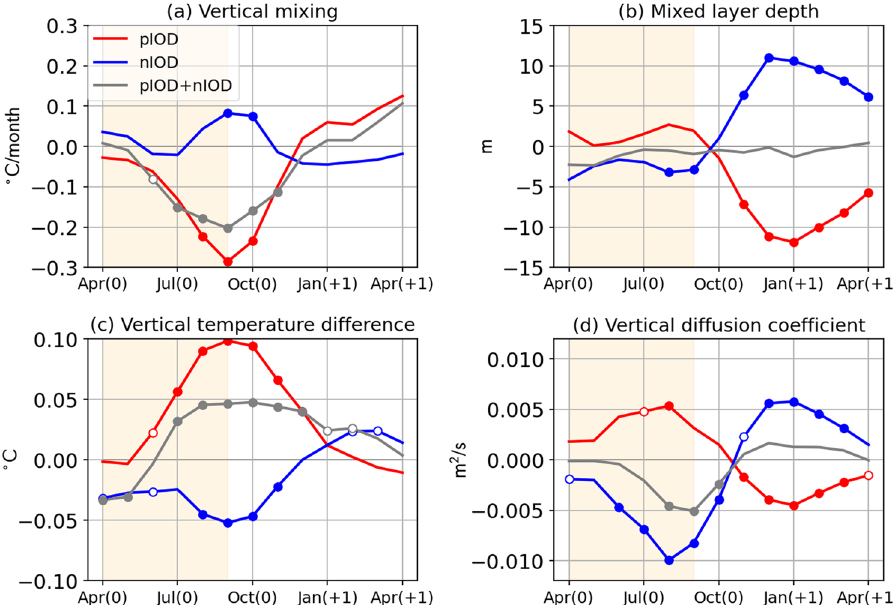
Figure 4. Vertical mixing term and its constituents during pIOD and nIOD years. Time series of composited ( a ) vertical mixing term (in °C/month), ( b ) mixed layer depth (MLD) (in m), ( c ) difference in temperature between the mixed layer and just below it (in °C), and ( d ) vertical diffusion coefficient (in m for the pIOD (red), the nIOD (blue), and the sum of pIOD and nIOD events (grey). The closed (open) circles indicate anomalies significant at the 95% (90%) confidence level by a two-tailed t test. The development phase is shaded.